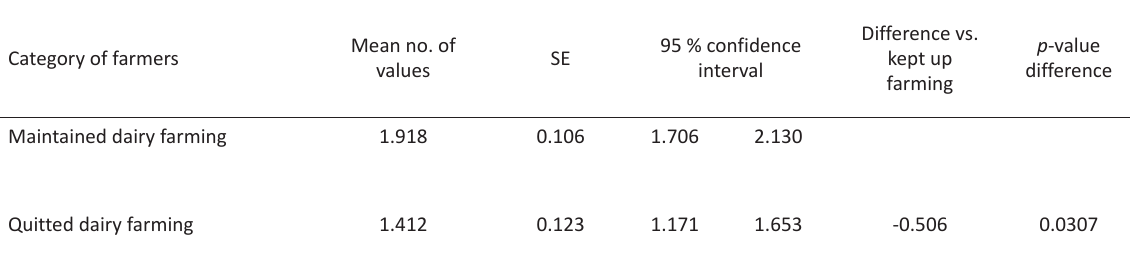
Quitted dairy farming 1.412